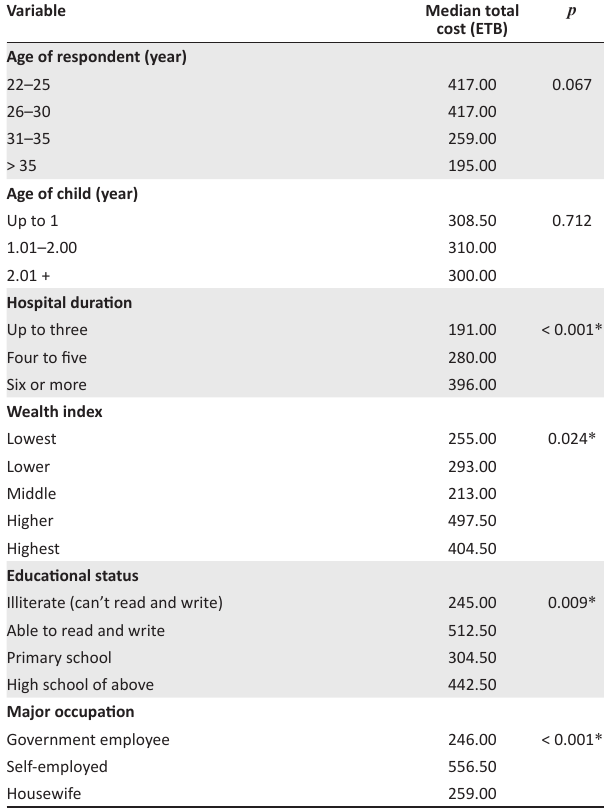
TABLE 4: Kruskal–Wallis test of difference in the median total cost.